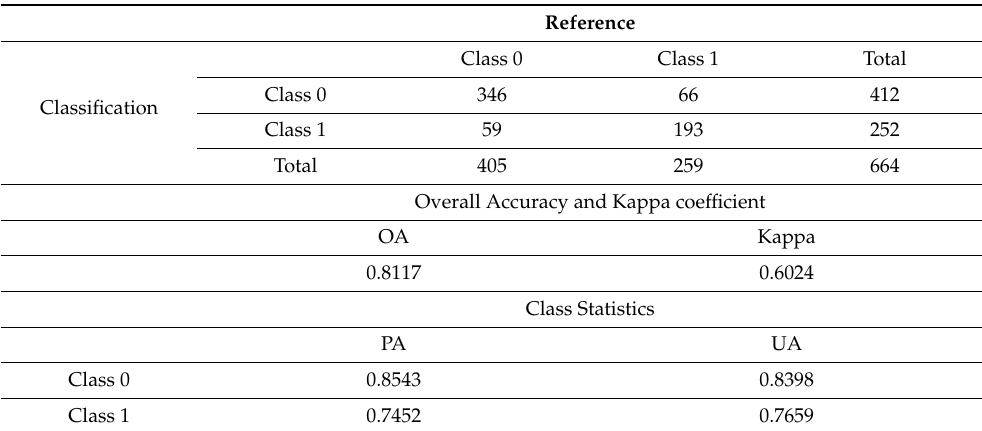
Table A1. PS classification (“scheme 1”).